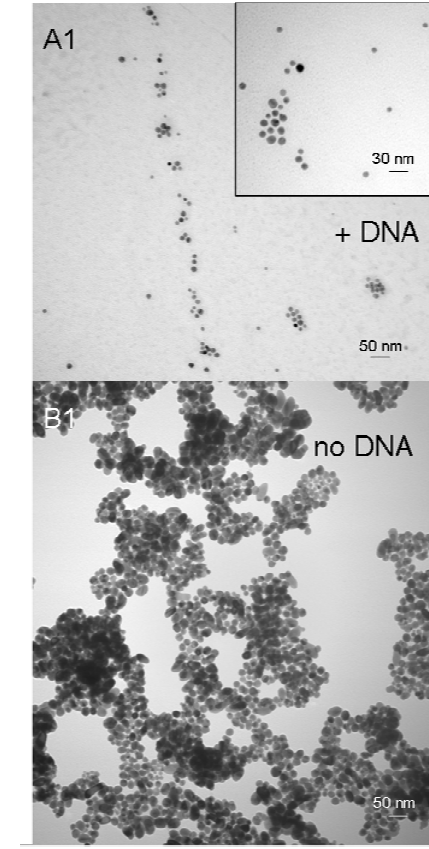
Figure 3. ( A ) UV-visible spectrum and corresponding TEM image (A1) of DNA samples incubated with gold phosphine solution for 7 h at 70 °C in the dark; Inset panel: higher magnification of sample in A1. ( B ) UV-visible spectrum and corresponding TEM image (B1) of TE buffer control incubated with gold phosphine solution under the same